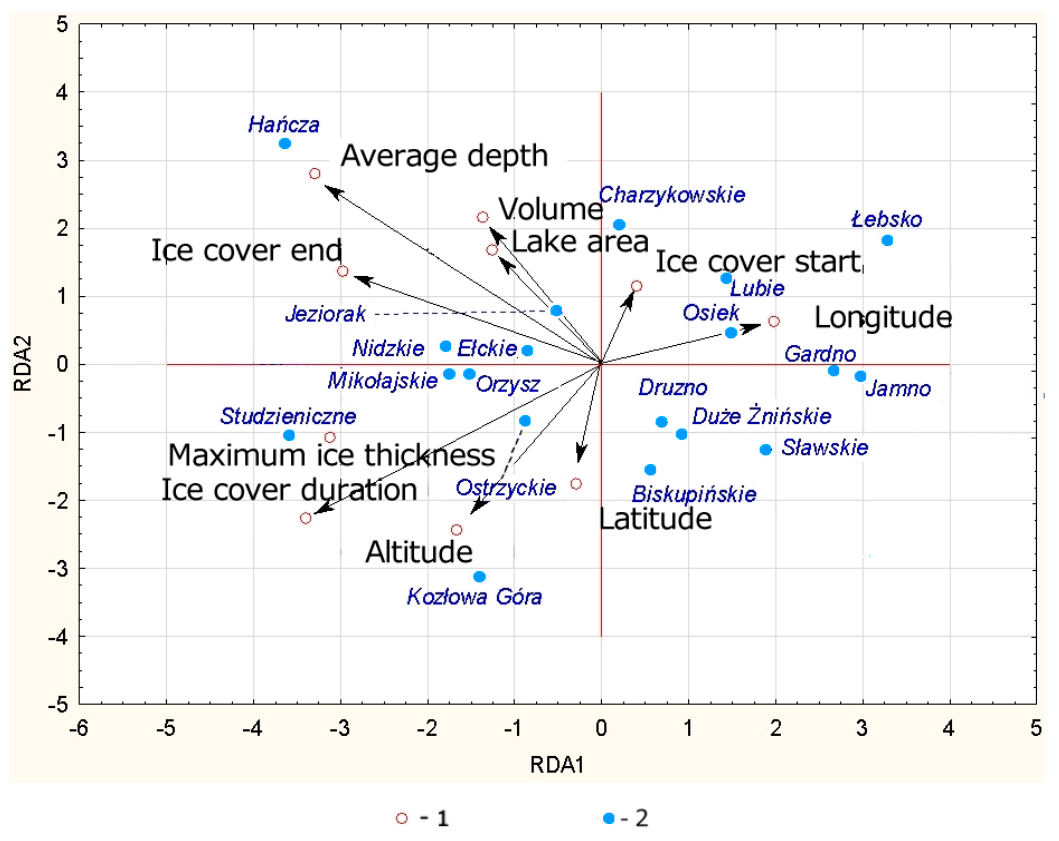
Figure 5. RDA biplots illustrating relations between environmental variables and selected parameters of lake ice phenology for the Kozłowa Góra reservoir and lakes in northeastern Poland and northwestern Poland: 1—correlated variables, 2—lakes examined.